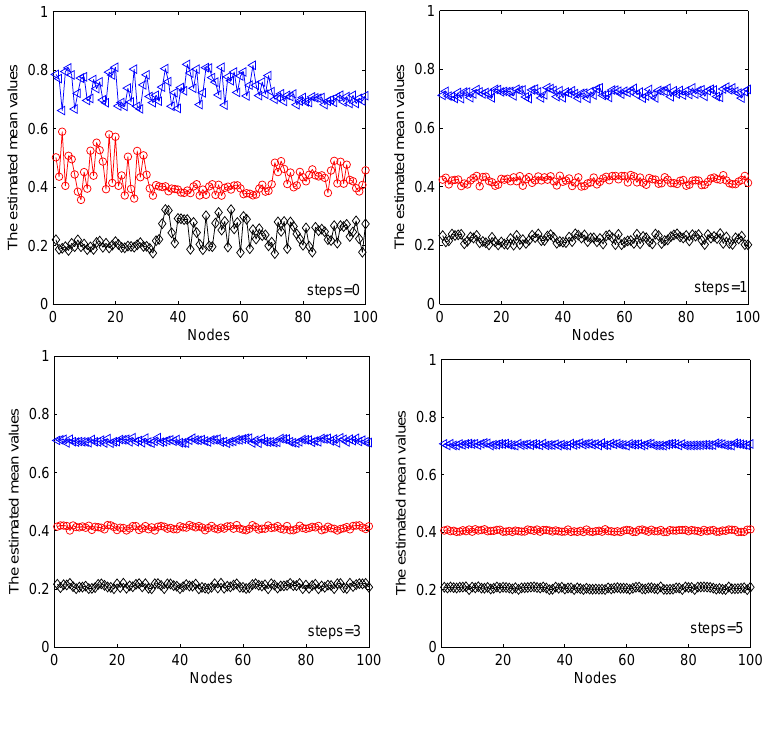
Figure 12. Estimated mean values versus steps of information